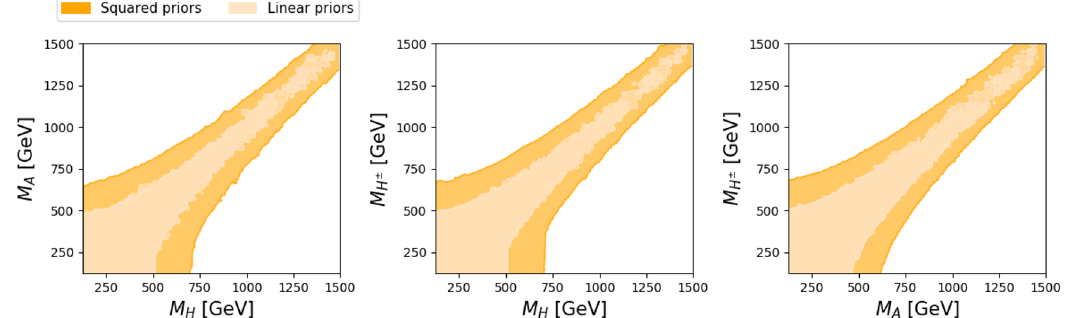
Figure 3. Theoretical constraints (100% probability) obtained with squared mass priors (dark orange) and linear mass priors (light